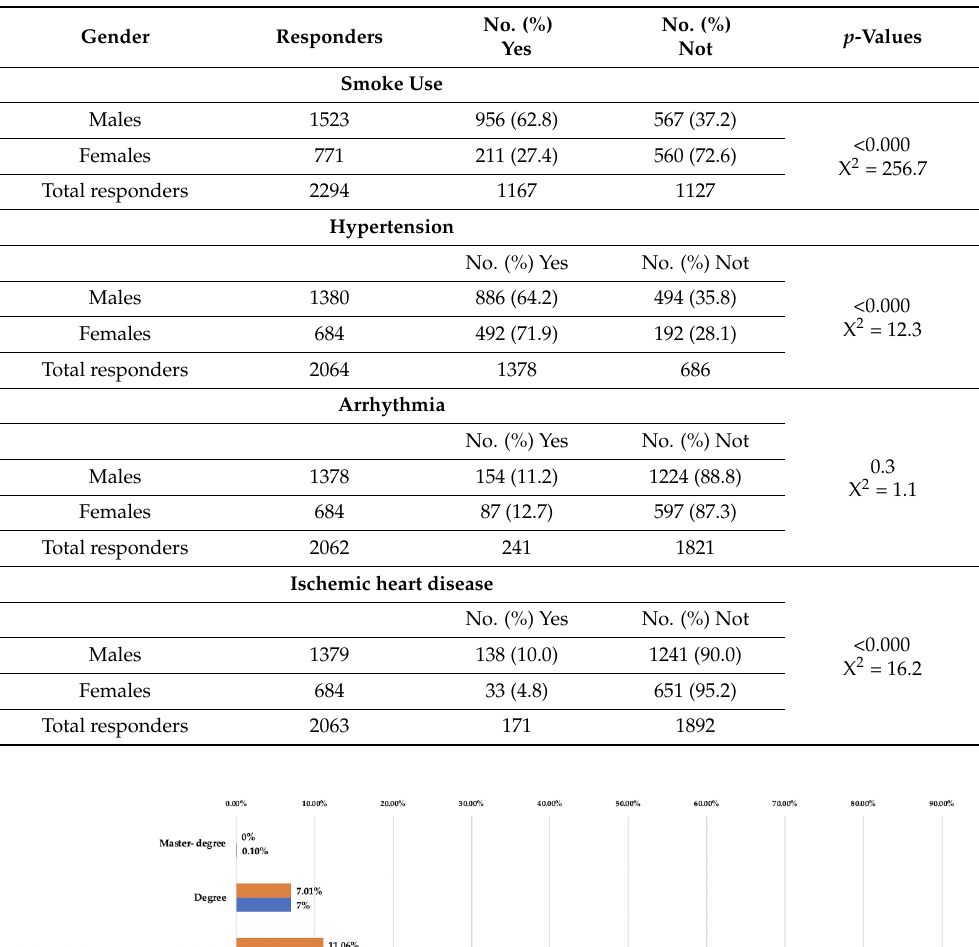
Table 2. Comorbidity distribution according to gender.